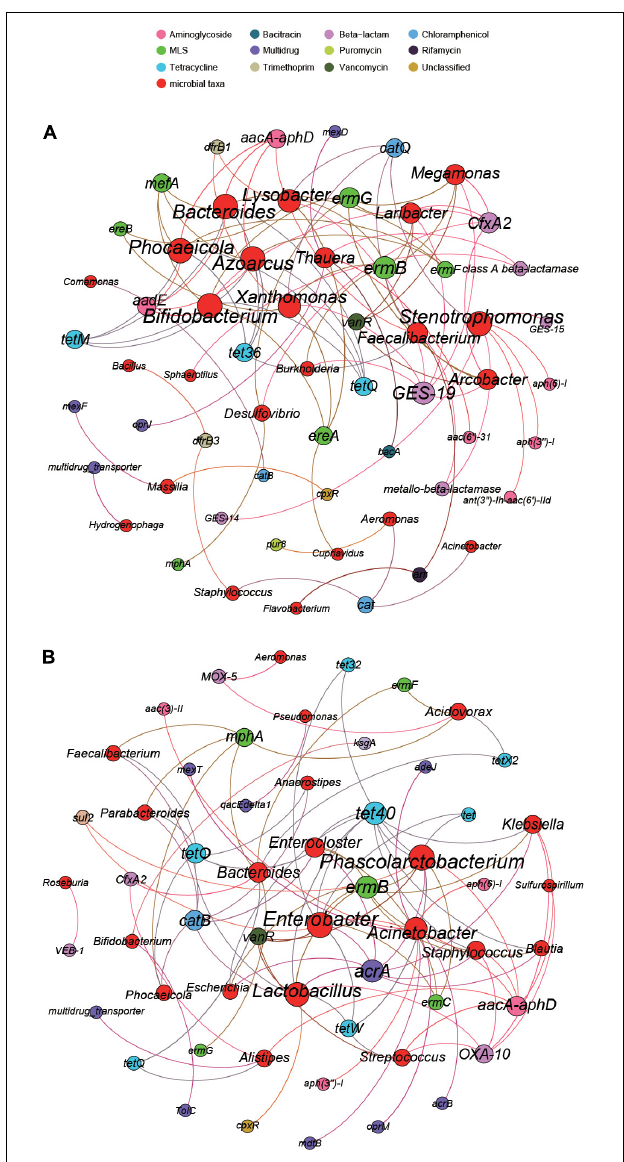
FIGURE 8 | The network analysis of eye hospital wastewater (A) and general hospital wastewater (B) revealing the co-occurrence patterns between ARG subtypes and microbial taxa. The nodes were colored according to ARG subtypes and microbial taxa. A connection represents a strong (Spearman’s correlation coefficient R 2 > 0.8) and significant ( P -value < 0.01) correlation. Edges weighted according to the correlation coefficient and node size weighted according to the number of